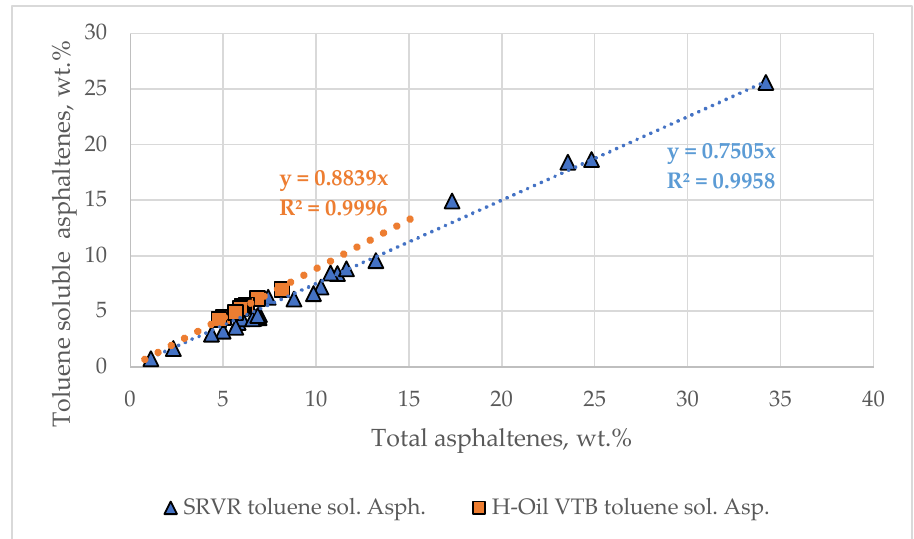
Figure 5. Relation of SAR-AD TM total asphaltene content to toluene-soluble asphaltene content.